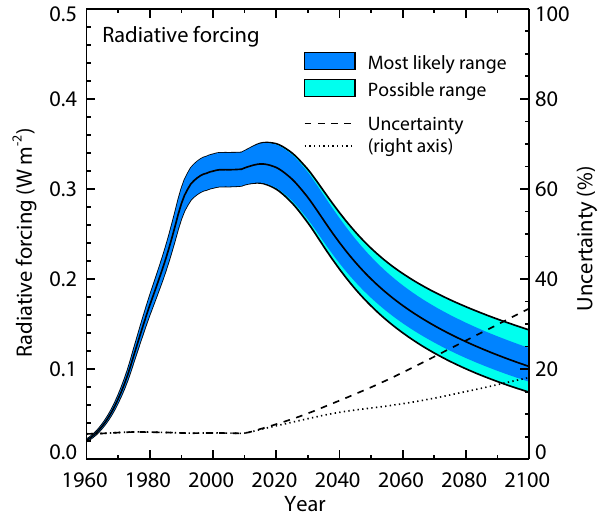
Fig. 8. Radiative forcing of all ODSs from 1960 to 2100 using the lifetimes from SPARC (2013) and with uncertainties applied to all parameters, including the radiative efficiencies. Shown are the median values and 95% confidence interval based on the possible (light blue) and most likely (dark blue) uncertainty ranges in the lifetime contributions to the total uncertainties. The relative uncer- tainties (95% confidence interval) are also shown as percentages of the median for the possible (dashed line) and most likely (dotted line)